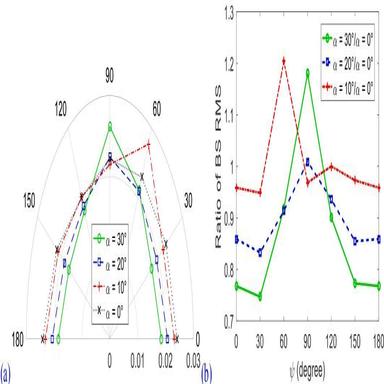
Comparison results of BS RMS values associated with different beam steering angles within effective bandwidth. (a) Polar diagrams of RMS value as a function of rotation angle ψ, and (b) the normalized BS RMS value against the 0◦ beam angle.